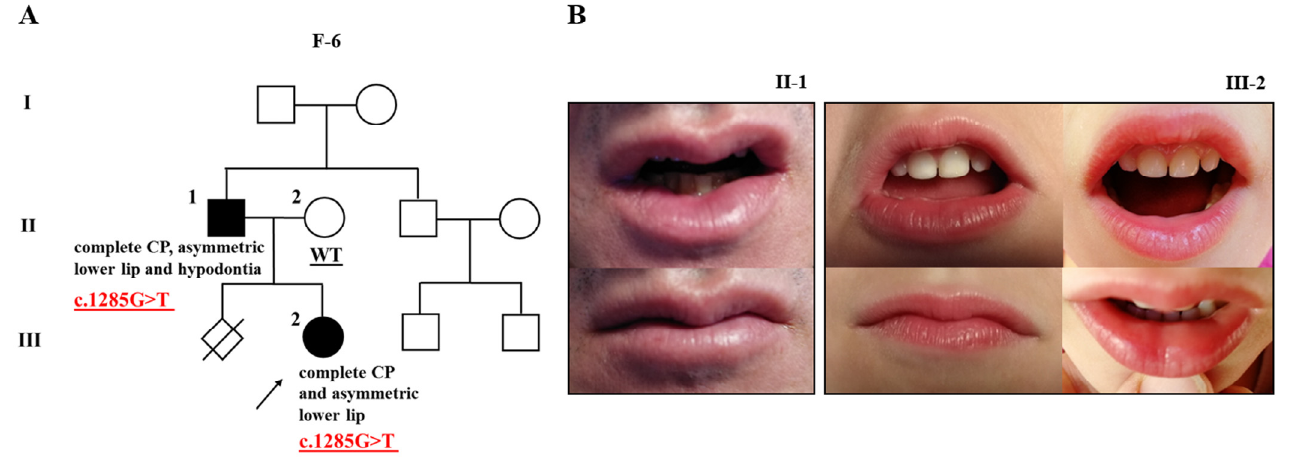
Figure 2. Pedigree of family 6 (F-6) with cleft palate, subtle Van der Woude syndrome sign, and mutation in GRHL3 ( A ); two affected individuals (F-6; II-1 and III-2) of the family showing an asymmetric lower lip without lip pits ( B ). The proband is marked with an arrowhead. Genotype is given underneath each genetically tested individual. Roman numerals stand for the generations, while Arabic numerals stand for the individual members of the family. CP, cleft palate.